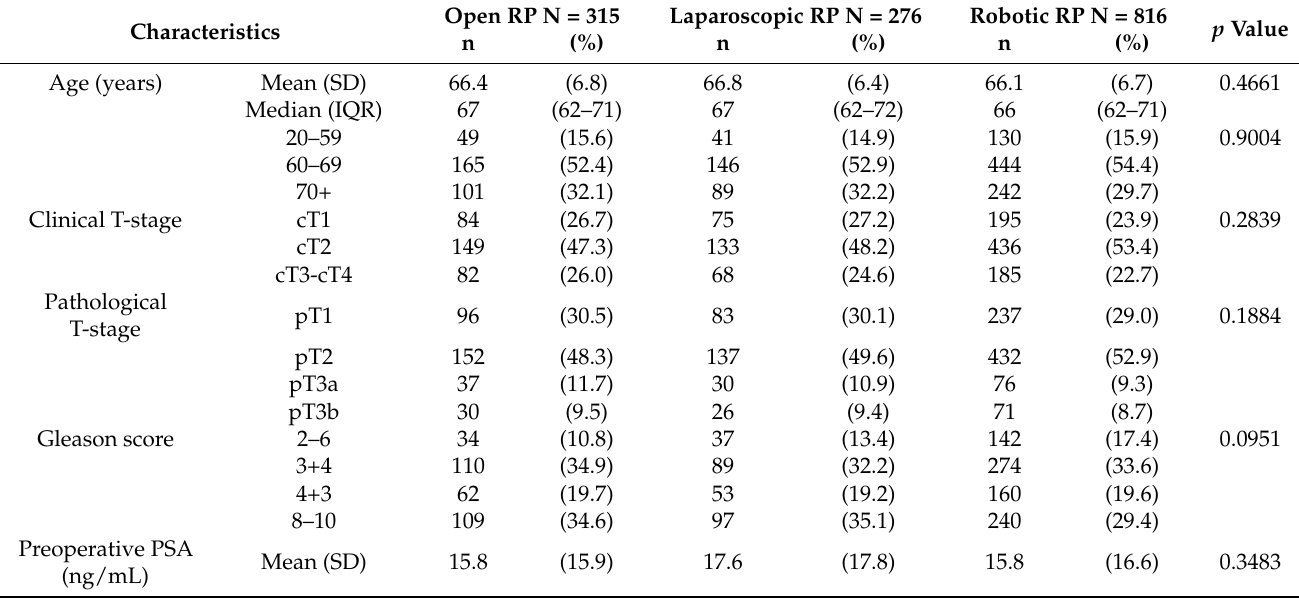
Table 1. Demographic and clinicopathological characteristics stratified by open, laparoscopic, and robotic RP.